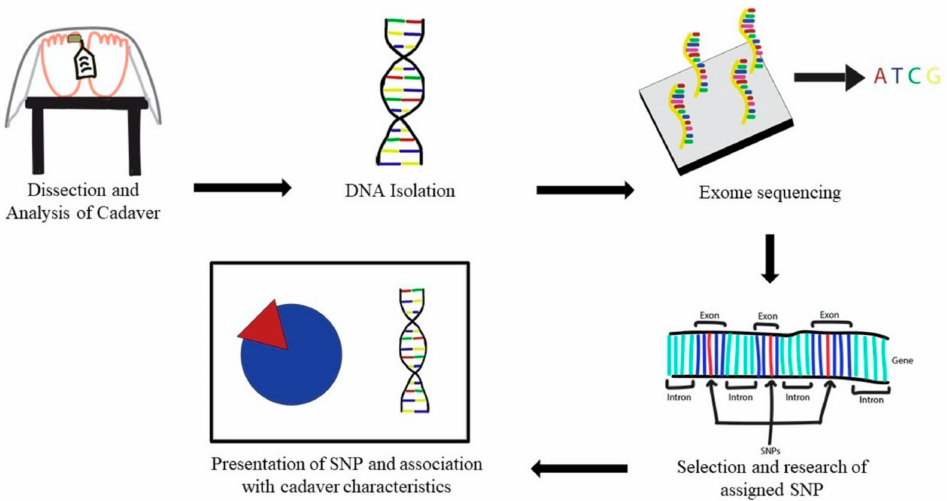
Figure 3. Workflow of first-year medical anatomy lab and genomics. Cadavers are dissected by students and traits about the cadaver are observed and recorded. DNA samples are isolated from various organs, including the heart and liver. Samples are sequenced and professors assign SNPs to di ff erent student groups who characterize the SNPs and associate them with cadaver traits. The students present their research in a 15-minute PowerPoint presentation